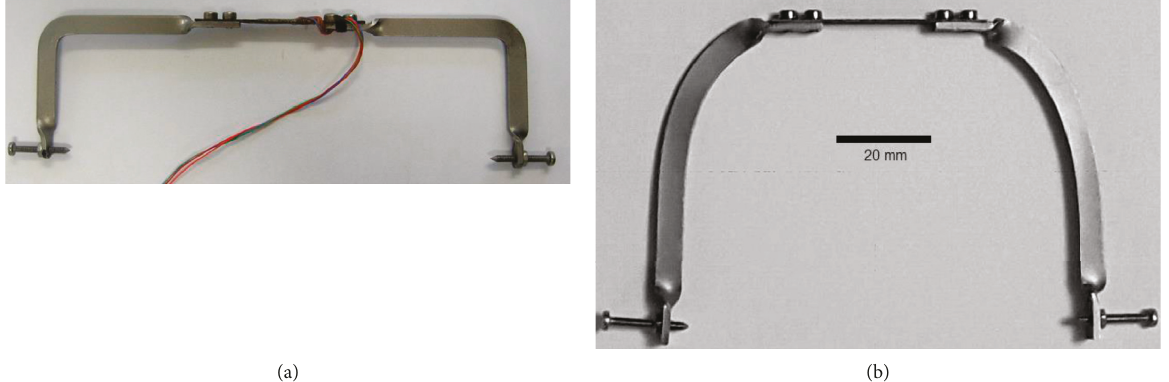
Figure 3: (a) Typical axial SDG and (b) typical radial SDG used in this study.